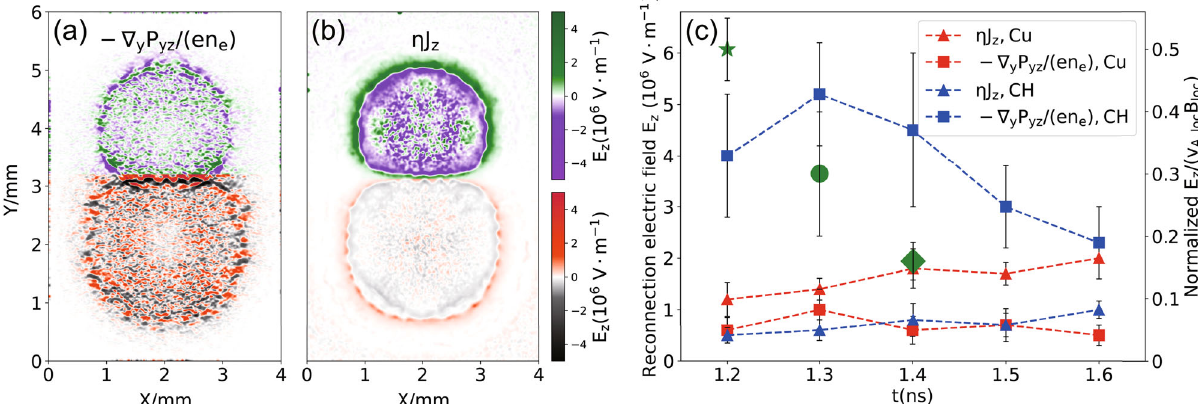
Fig. 5 Contribution terms of the reconnection electric fi eld E z in the hybrid magnetic reconnection. a and b are respectively the contributions from the off-diagonal (nongyrotropic) component of the electron pressure tensor E z ; p the setup in experiment, the upper half part is collisional Cu plasma (where E z is quanti fi ed using the colormap scale from purple to green colors) and the lower half part is collisionless CH plasma (where E z is quanti fi ed using the colormap scale from black to red colors). c shows their contributions varying with time from t = 1.2 to 1.6 ns for respectively Cu and CH plasmas during reconnection, the error bars represent one standard deviation. The normalized reconnection electric fi eld E z (normalized to local Alfvén speed v A , loc and magnetic fi eld B loc ) for respectively the cases of purely collisionless CH-CH (green star), hybrid Cu-CH (green circle) and purely collisional Cu-Cu (green diamond) reconnections are also marked in ( c ), where all the values are chosen at the time when the changes of their magnetic fi eld topologies are most signi fi